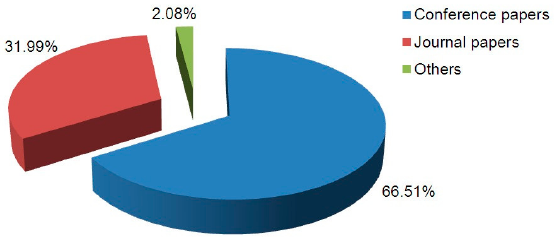
Figure 2. Distribution of publications according to their type.